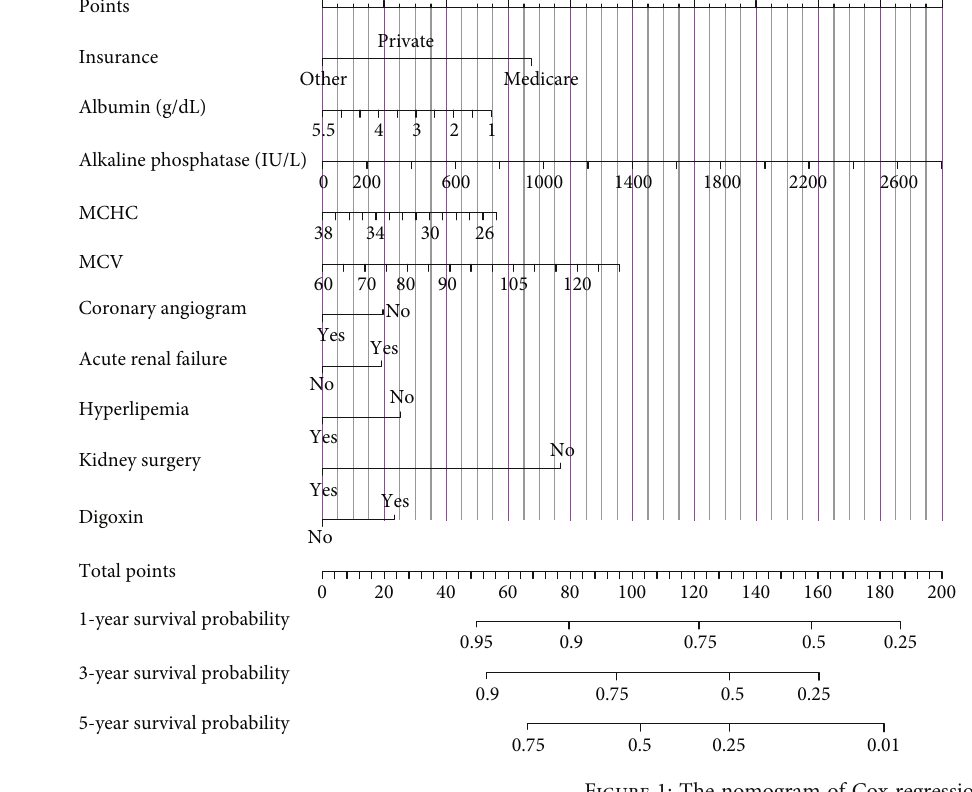
Figure 1: The nomogram of Cox regression model.